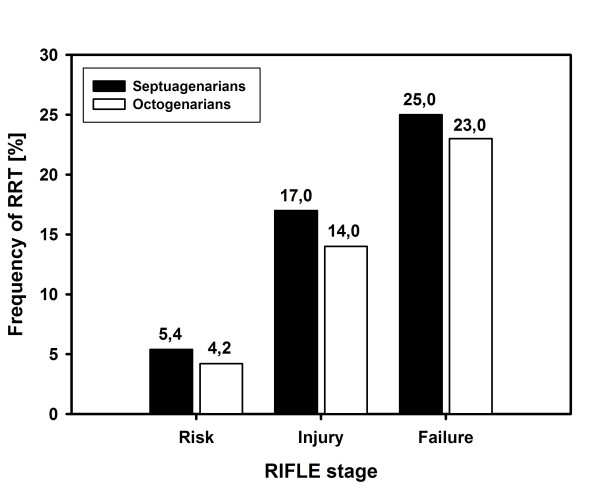
Bar graph depicting the stepwise in increase (in %) of renal replacement therapy (RRT) according to advanced RIFLE stages in septua- and octogenarians. There were no significant differences between both groups at the indicated RIFLES stages.